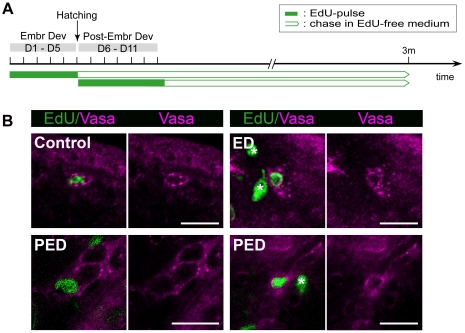
Identification of label-retaining neoblasts (Macvasa).Identification of neoblasts among the population of LRCs, using an antibody against neoblast-specific Macvasa proteins. (A): Scheme of the experimental set-up. Animals were pulsed continuously with EdU during embryonic development (day1–day5) and during post-embryonic development (day6–day11), followed by a chase time of 3 months in EdU-free medium. Subsequently, EdU was visualized in combination with Macvasa. (B): Visualization of label-retaining neoblasts in whole-mount animals (confocal image). LRCs (EdU) are green. The TRITC-signal of the Macvasa proteins, was converted to magenta. EdU+/Macvasa+ cell in a control animal (no chase) displays Macvasa proteins in a ring of nuage around the nucleus (upper left panel). EdU+/Macvasa+ cell in an animal pulsed during ED (upper right panel). EdU+/Macvasa+ cells in an animal pulsed during PED (lower left and right panel). LRCs that are Macvasa-negative (asterisks) are visible in individuals pulsed during ED and PED (right panels). Abbreviations: EdU, 5-ethynyl-2′-deoxyuridine; Vasa, Macvasa; ED, embryonic development; PED, post-embryonic development. Scale bars: 10 µm.